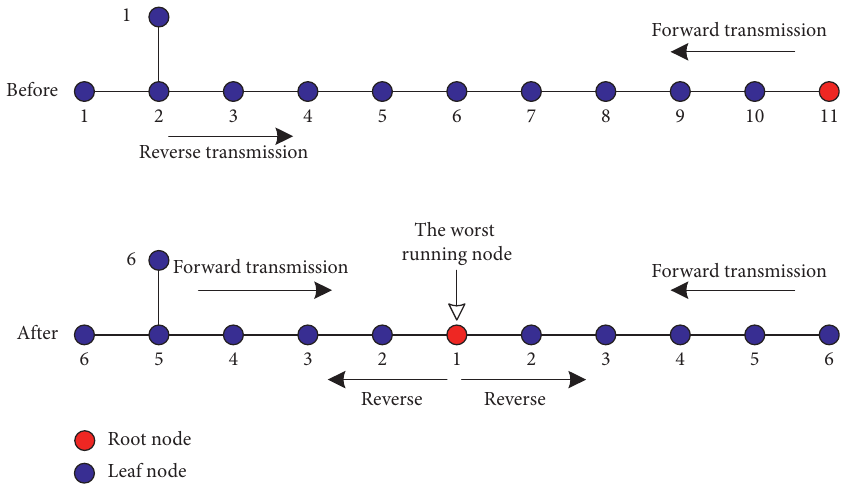
Figure 4: Optimization of the JTA information transmission